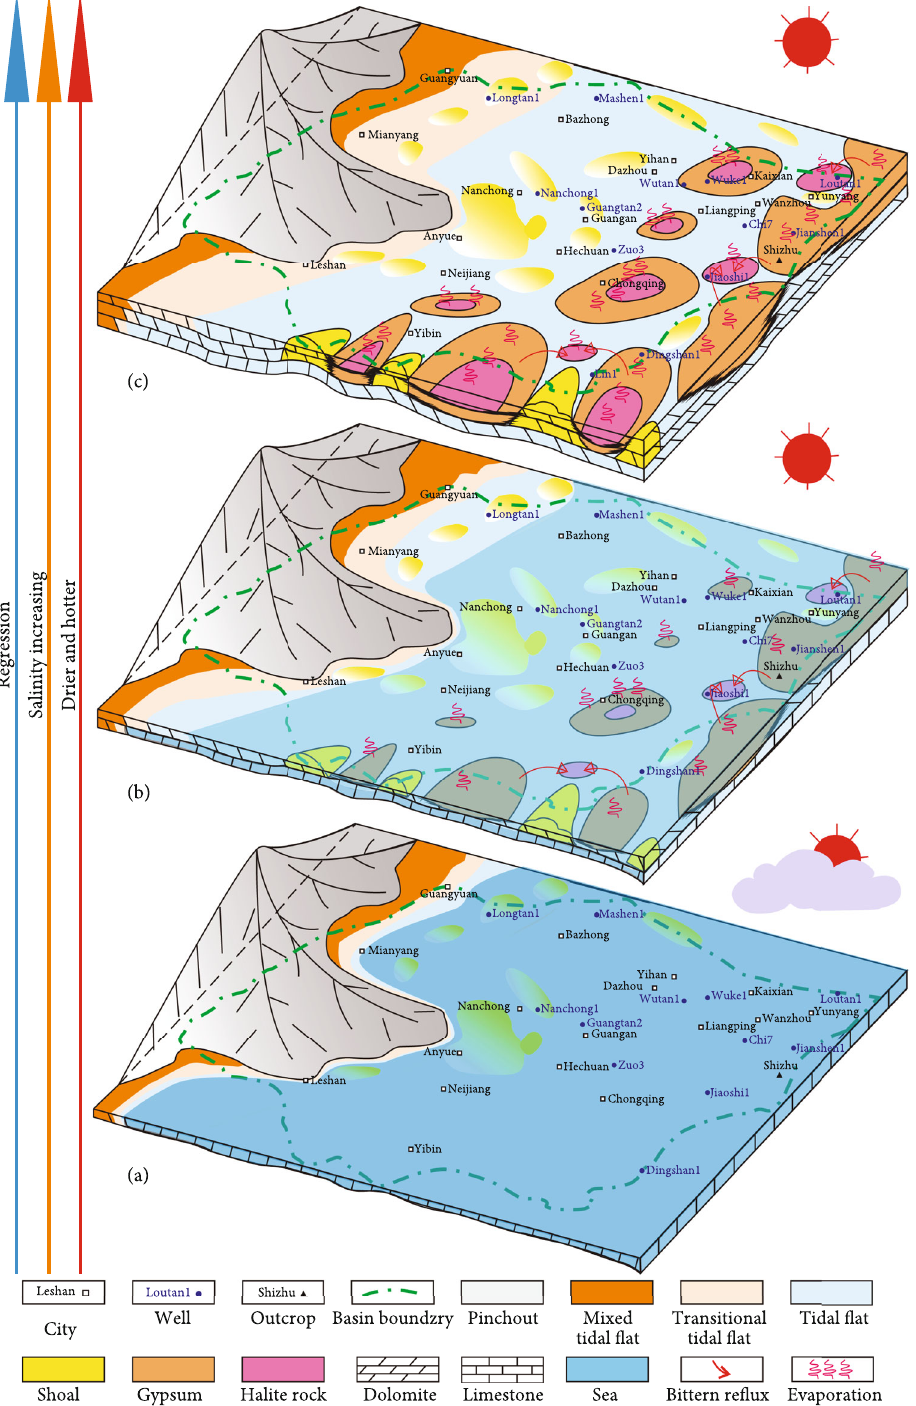
Figure 12: The formation mode of